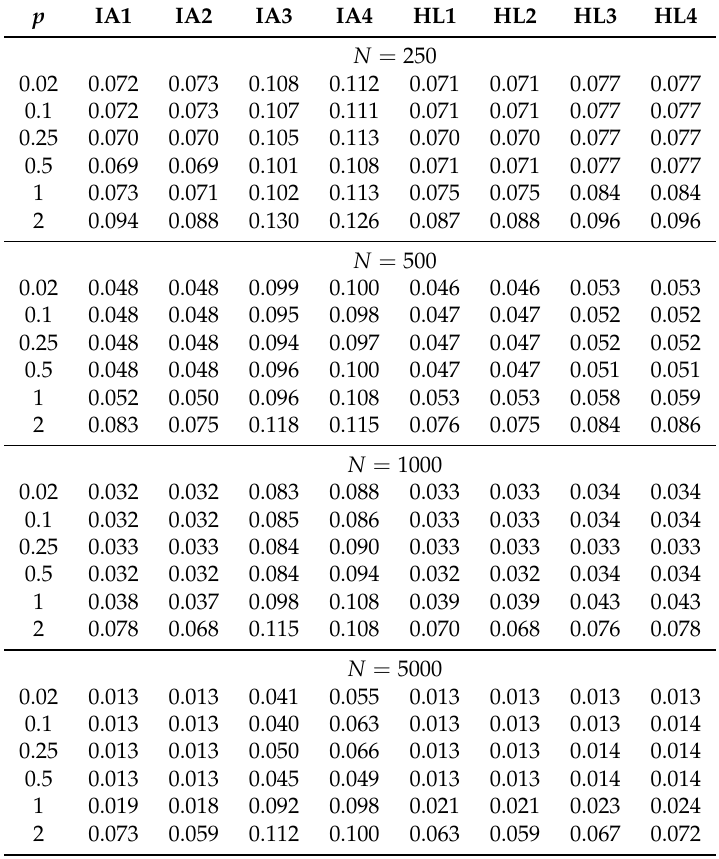
Table 2. Simulation Study 1: Average Root Mean Square Error (ARMSE) of Group Means as a Function of Sample Size in the Condition of Differential Item Functioning (DIF) and G = 6